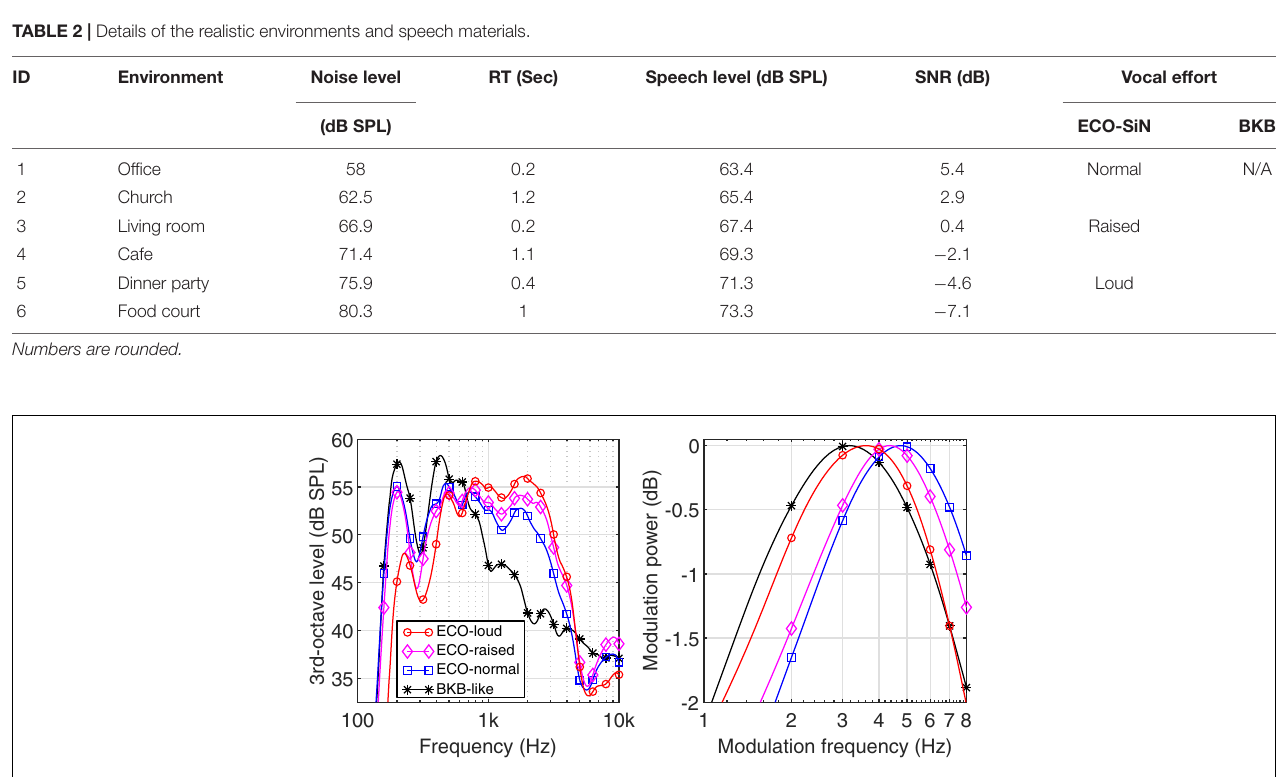
TABLE 2 | Details of the realistic environments and speech materials.